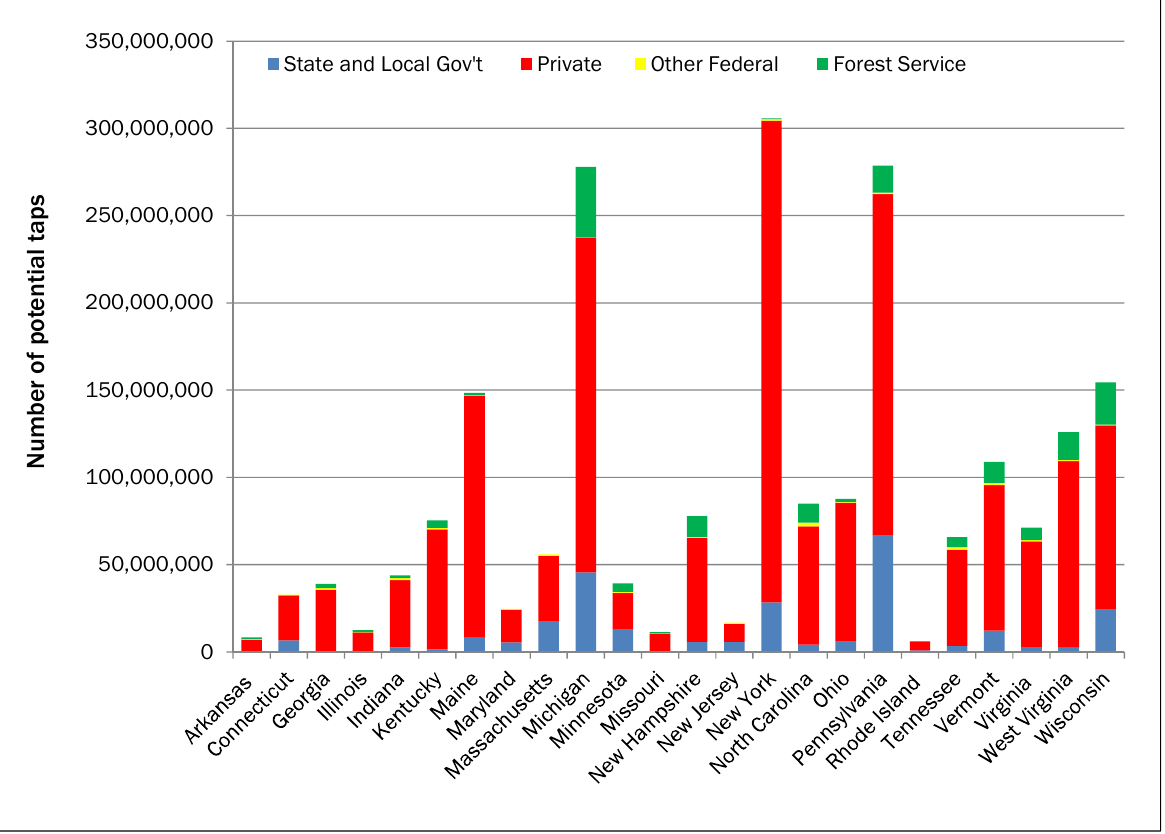
Source: U.S. Department of Agriculture, Forest Service.